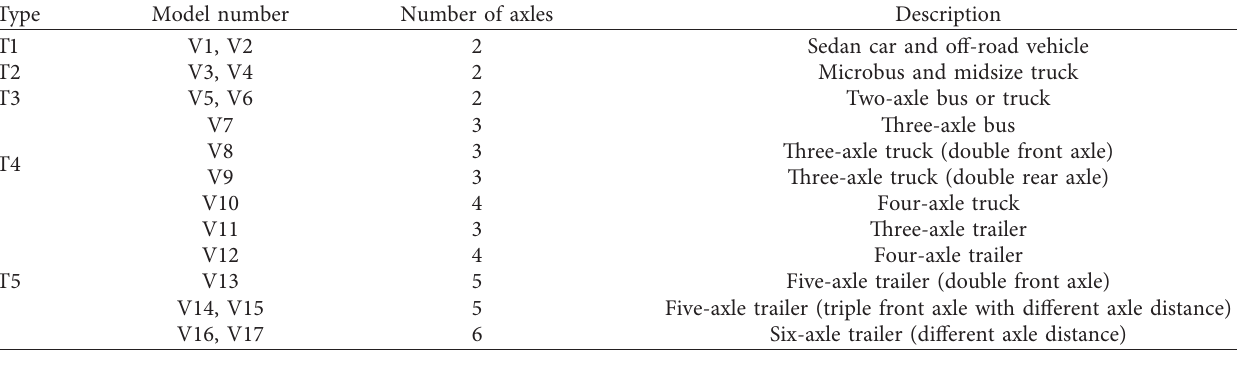
Table 1: Vehicle classification [20, 21].